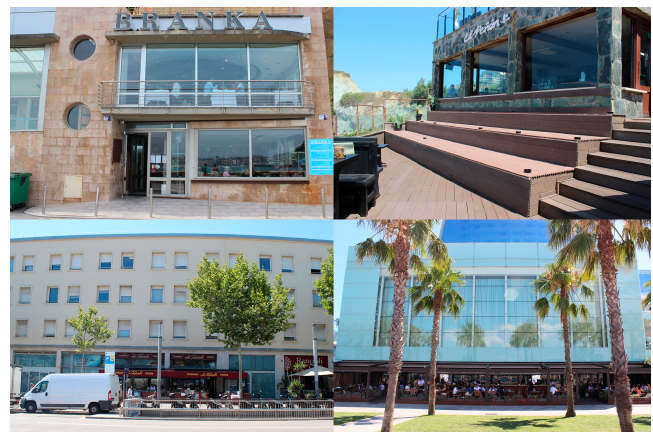
Figure 1. Glazed façades of restaurants without overall building façade integration. In the first row, restaurants with glazed façades in Zarautz (nearby Bilbao); in the second row, restaurants with glazed façades in La Barceloneta (neighborhood of